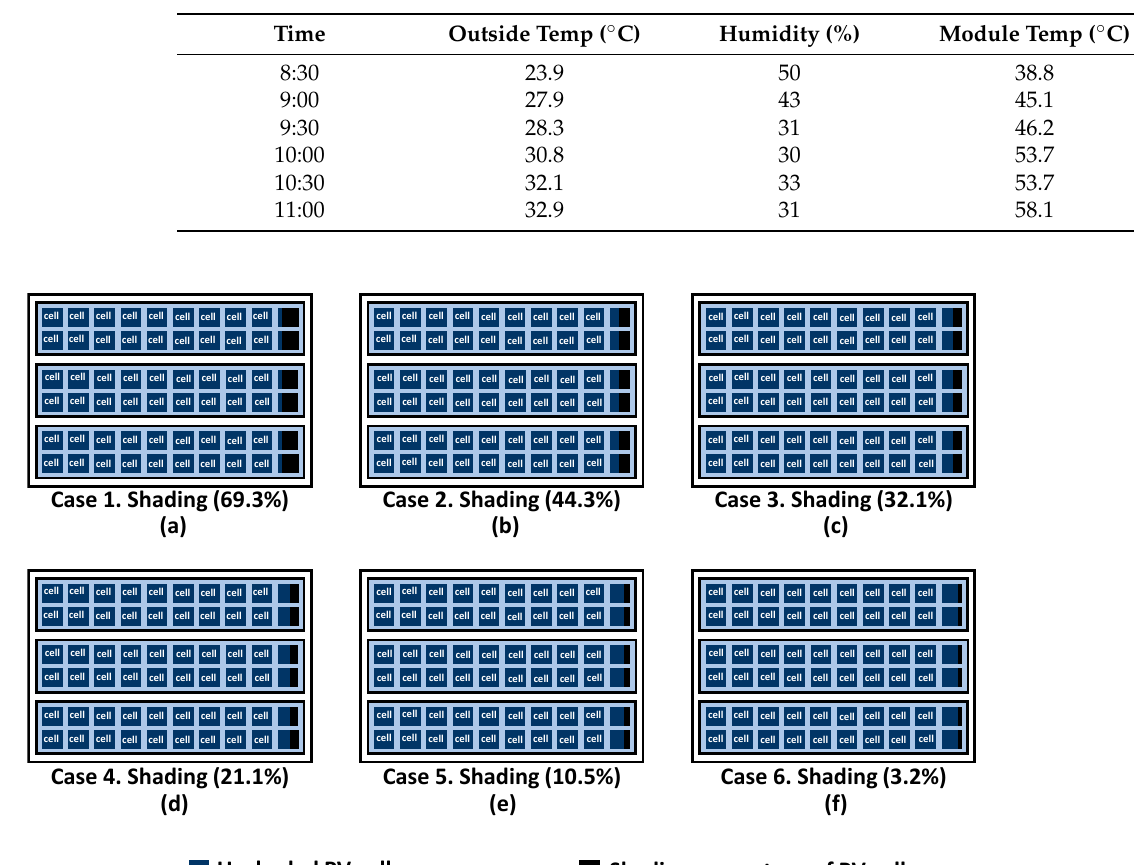
Figure 3. PV array in a series configuration and the load profile. Table 2. Measured values during the experiment.